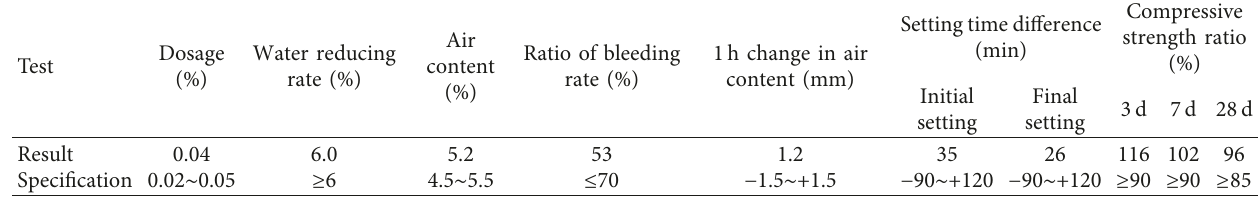
Table 4: Properties of air entraining admixture.